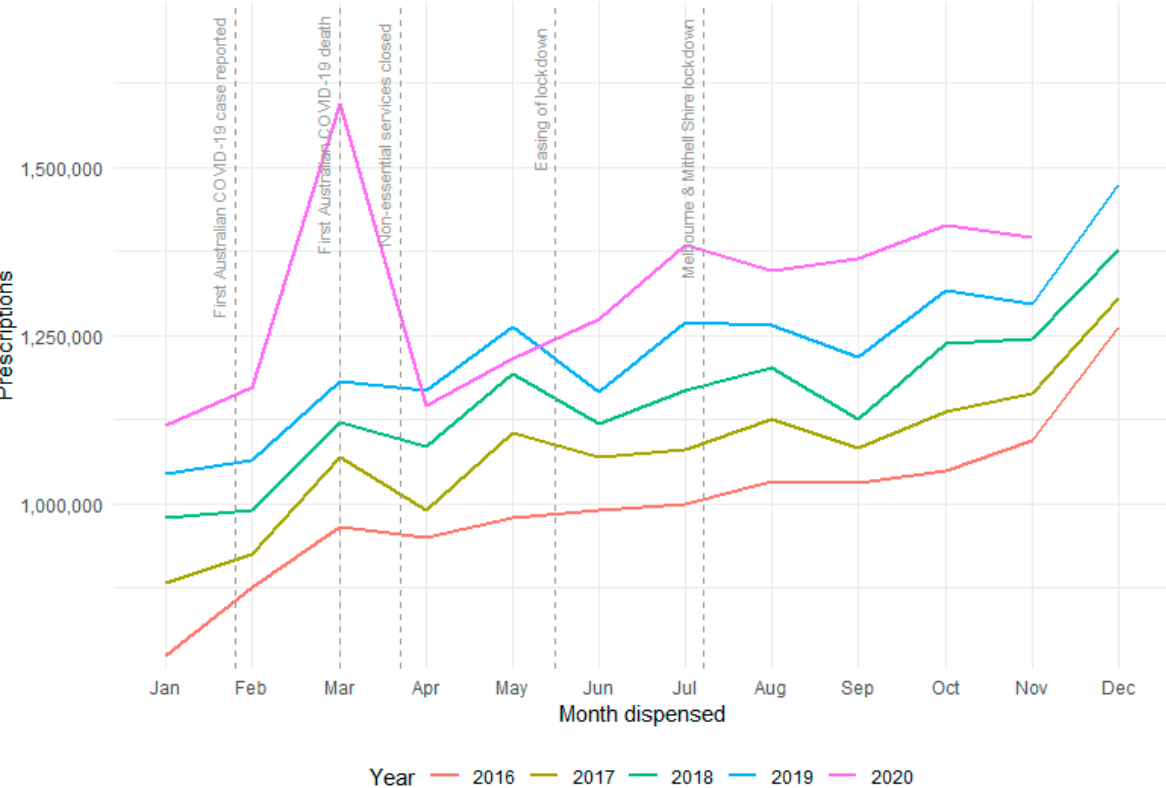
Figure 1. PBS dispensed diabetes medicines by